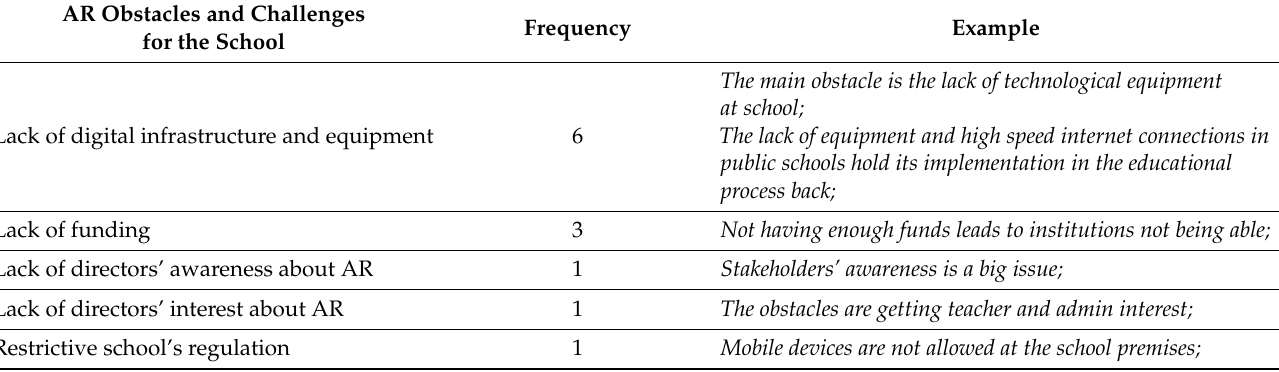
Table 16. School’s obstacles and challenges in integrating